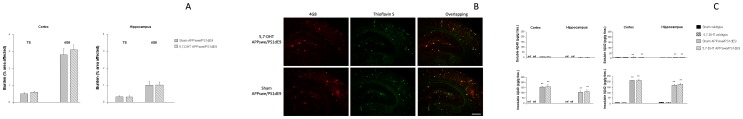
Aβ plaques and levels are not affected in denervated areas after 5,7-DHT administration.
A) Although a relative increase of thioflavin S was observed in the cortex from APPswe/PS1dE9 lesioned mice, differences did not reach statistical significance when compared with sham treated mice, using Student t test for independent samples (thioflavin S, p = 0.382), and the same pattern was observed after anti-Aβ immunohystochemistry (4G8, p = 0.525). Similarly, no differences were observed in the hippocampus of denervated mice (Thioflavin S p = 0.665; anti-Aβ p = 0.729). B) Illustrative example of thioflavin S (green) and anti-Aβ (red) staining in the cortex and hippocampus of Sham APPswe/PS1dE9 mice and 5,7-DHT APPswe/PS1dE9 mice. Scale bar: 250 µm. C) Soluble and insoluble Aβ40 and Aβ42 levels were analyzed in the cortex and hippocampus. Since Aβ40 levels were undetectable in wildtype animals, Student t test for independent sample was used to compare Sham and 5,7-DHT APPswe/PS1dE9 mice. One way ANOVA followed by Tuckey b or Tamhane tests was used for the rest of the comparisons, as required. Cortex: Soluble Aβ40 p = 0.924, soluble Aβ42 [F(3,12) = 10.563, **p = 0.001 vs. sham wildtype and 5,7-DHT wildtype], insoluble Aβ40 p = 0.898, insoluble Aβ42 [F(3,12) = 365.243, **p = 0.001 vs. vs. sham wildtype and 5,7-DHT wildtype]. Hippocampus: Soluble Aβ40 p = 0.944, soluble Aβ42 [F(3,12) = 9.215, **p = 0.002 vs. sham wildtype and 5,7-DHT wildtype], insoluble Aβ40 p = 0.804, insoluble Aβ42 [F(3,12) = 165.855, **p<0.001 vs. sham wildtype and 5,7-DHT wildtype].